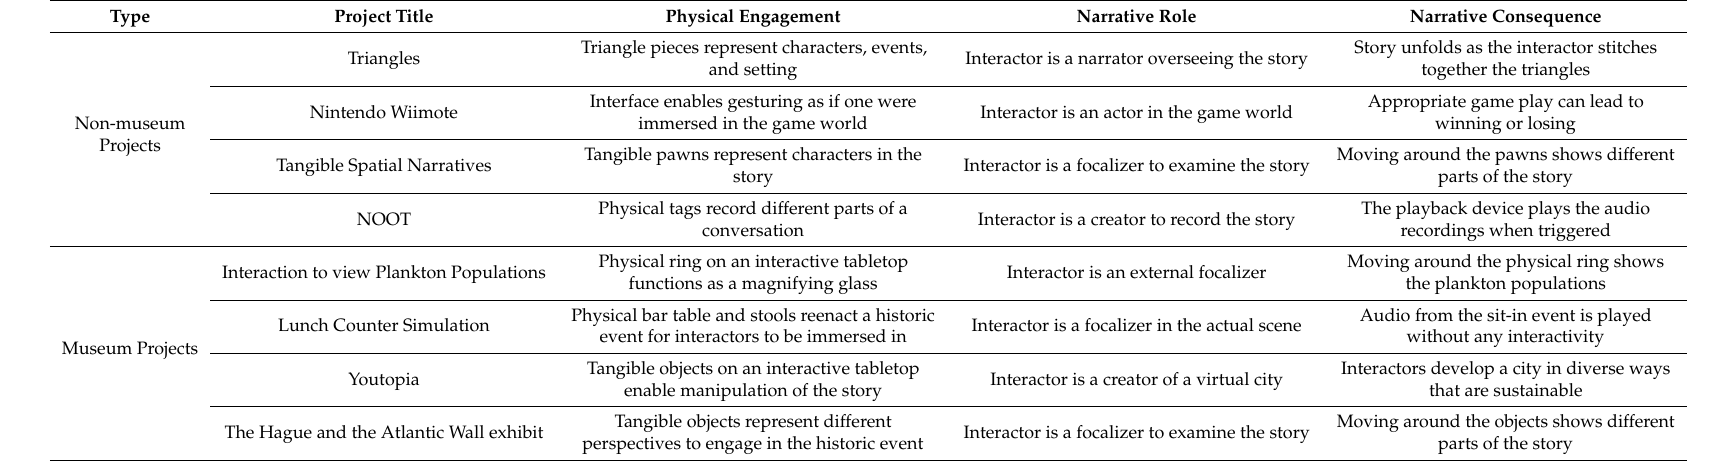
Table 1. Narrative design elements for a framework identified in existing